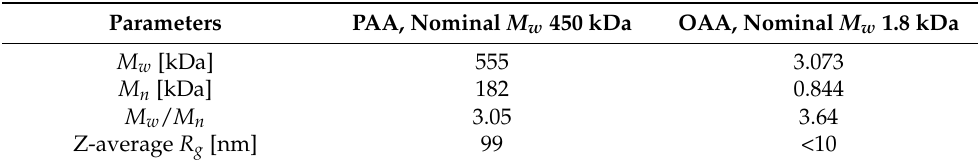
Table 1. Physicochemical parameters of PAA and OAA used in this study, measured by